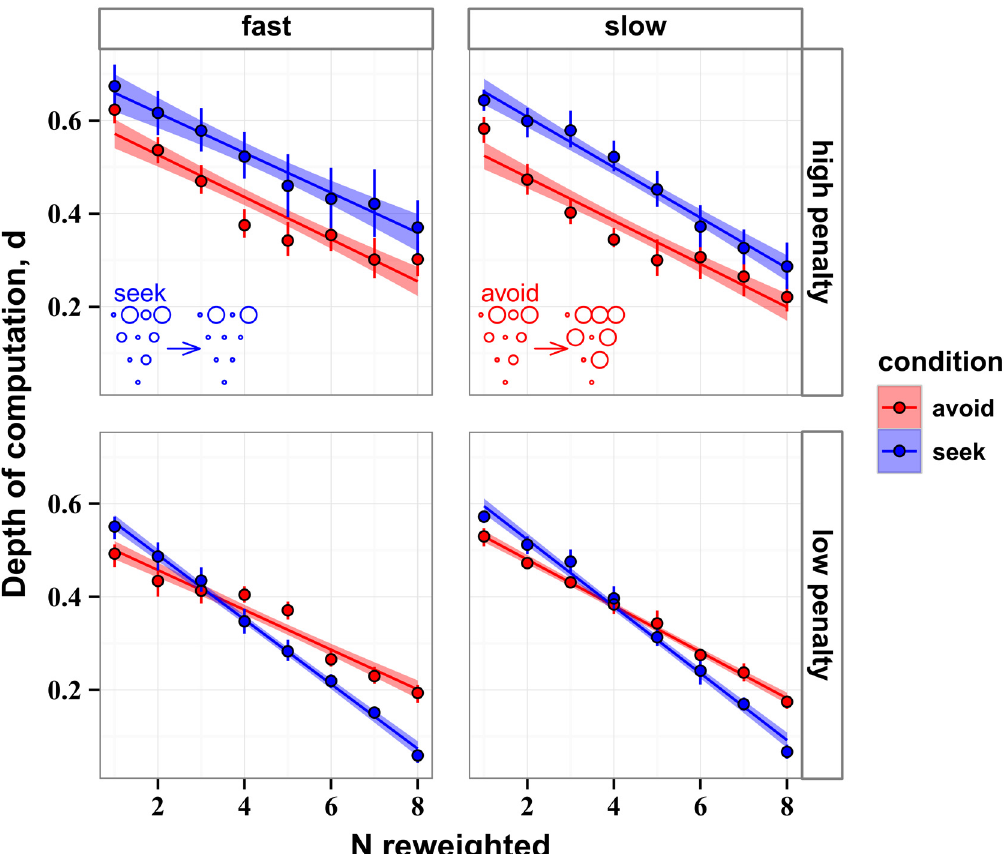
Fig 11. Results of the weighting analysis averaged over participants. Blue lines represent the effect of seeking out large disks and red lines represent the effect of avoiding small disks. The lines are the best fits to the data with the standard errors shaded. The points are the means with the 95% confidence intervals represented by the error bars. Top and bottom rows correspond to the conditions of high and low penalties of missing a disk, respectively. Left and right columns correspond to high and low speeds of the stimulus. The smaller values on the ordinate the larger the evidence that participants either sought out the largest disks (blue) or avoided the smaller disks (red). The fact that evidence is always positive indicates that participants never relied on these heuristics